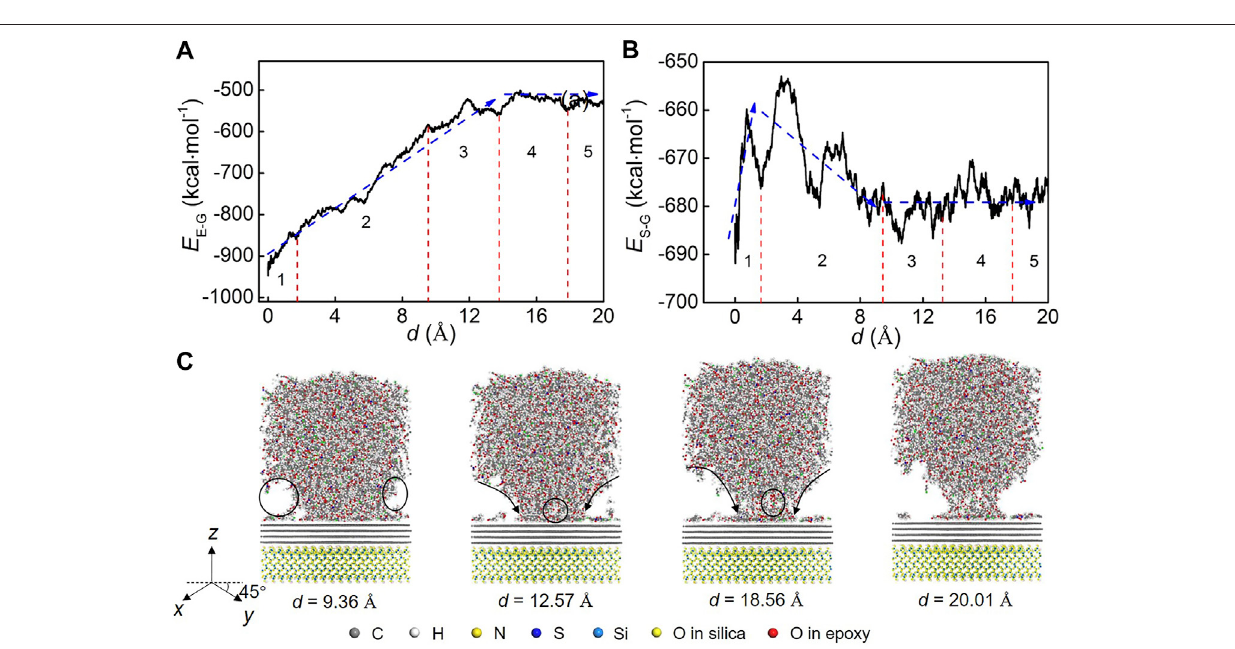
Frontiers in Materials |